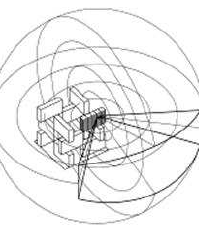
Figure 1: Spatial Openness Index (SOI) is defined as the volume of the part of a surrounding sphere which is visible from a given point of view.(Fisher-Gewirtzman&Wagner, 2003).